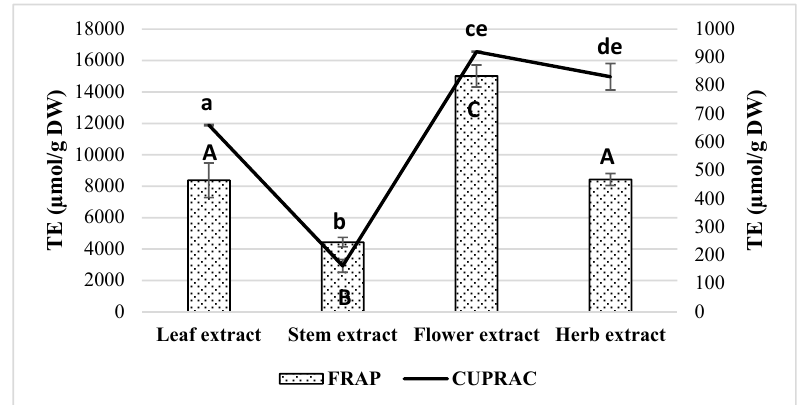
Figure 3. Antioxidant (FRAP and CUPRAC) activities of ethanolic E. ciliata extracts. Results are means ± SD. Values with different capital (FRAP) and lowercase (CUPRAC) letter(s) are significantly different ( p < 0.05) measured by Tukey‘s test.